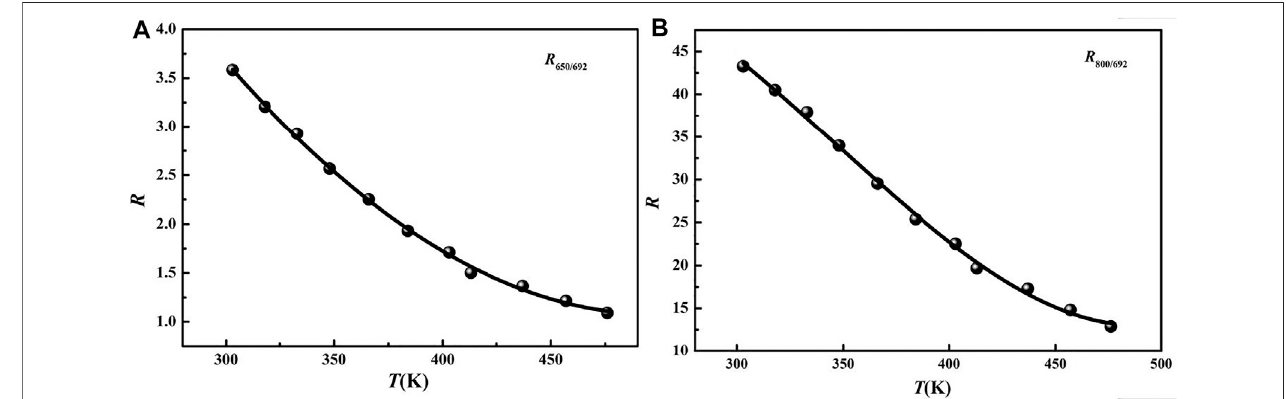
FIGURE 7 | Temperature-dependent (A) R 650/692 and (B) R 800/692.